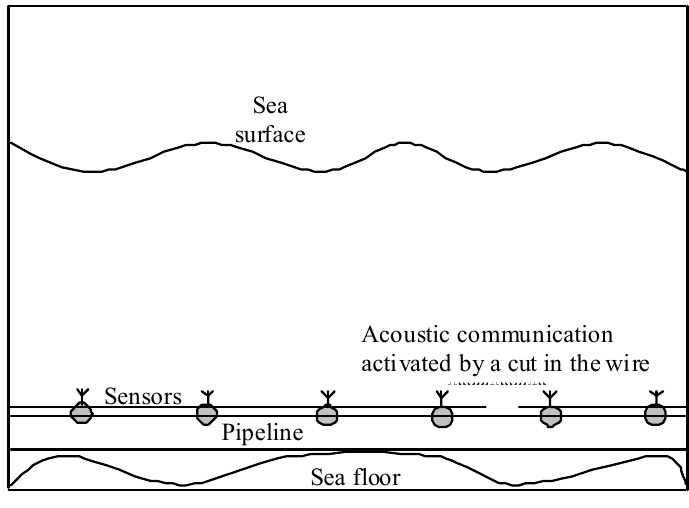
Figure 6. Integrated wired/acoustic wireless sensor